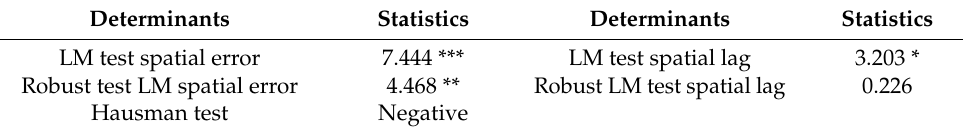
Table 4. Results of model